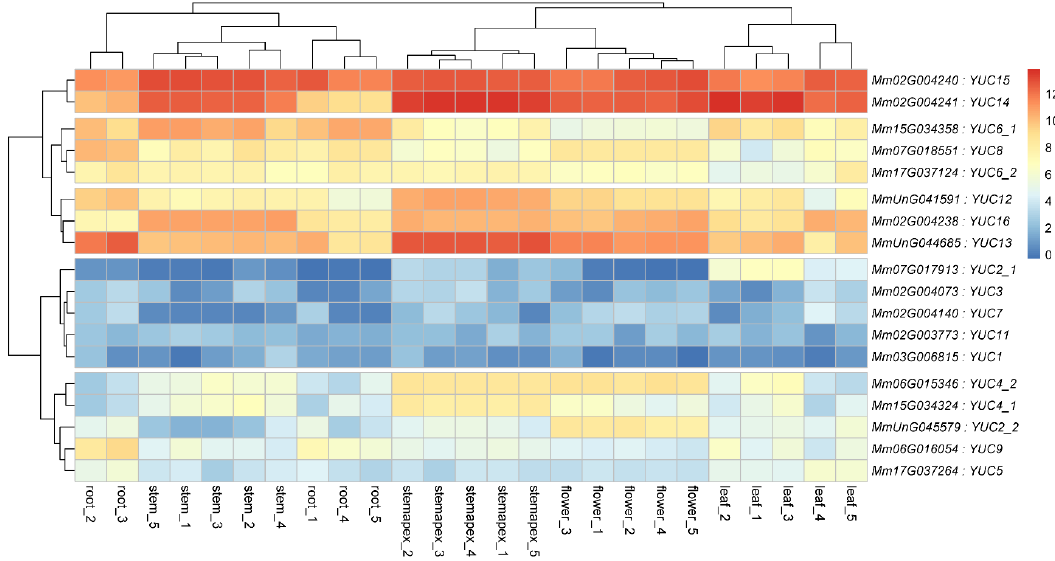
Figure 3. Heat map of the expression patterns of MmYUC genes in different tissues.